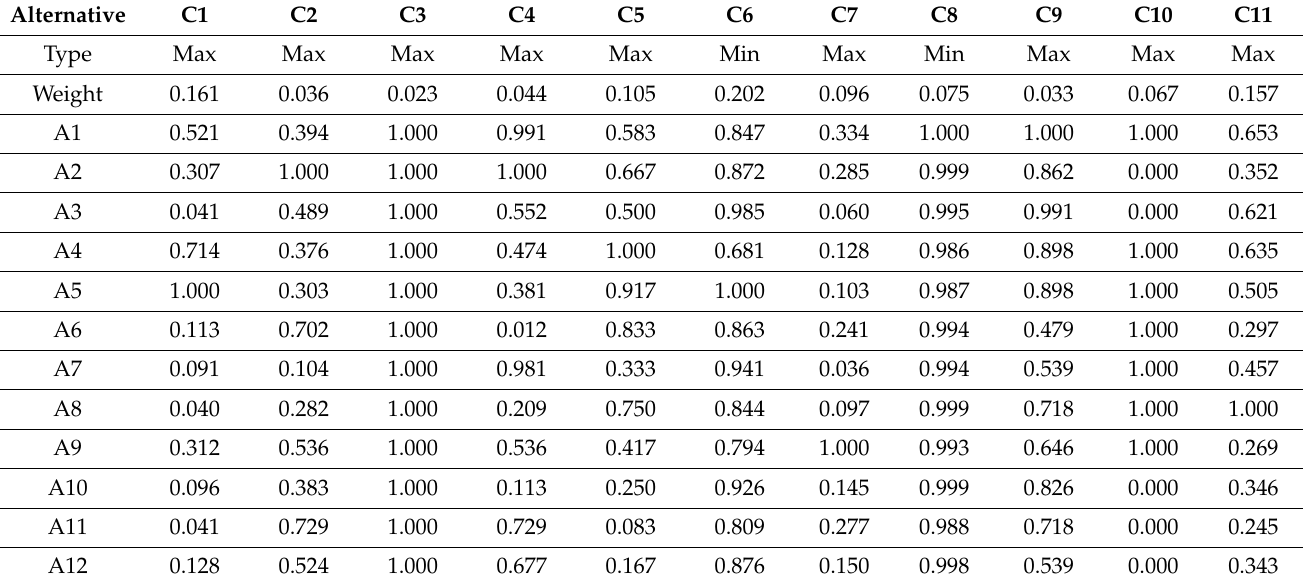
Table 6. The weighted matrix decision.